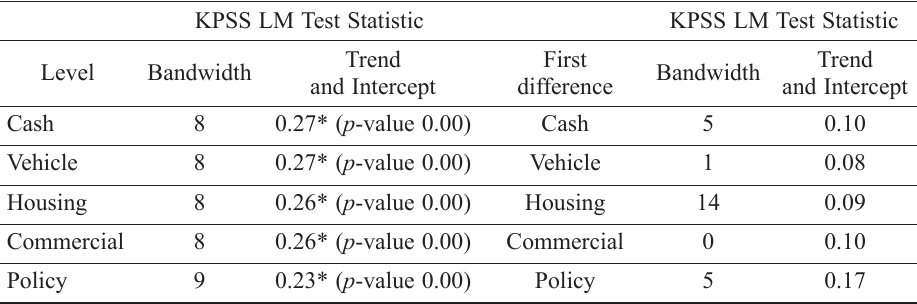
Table 3. KPSS unit root test results for all series